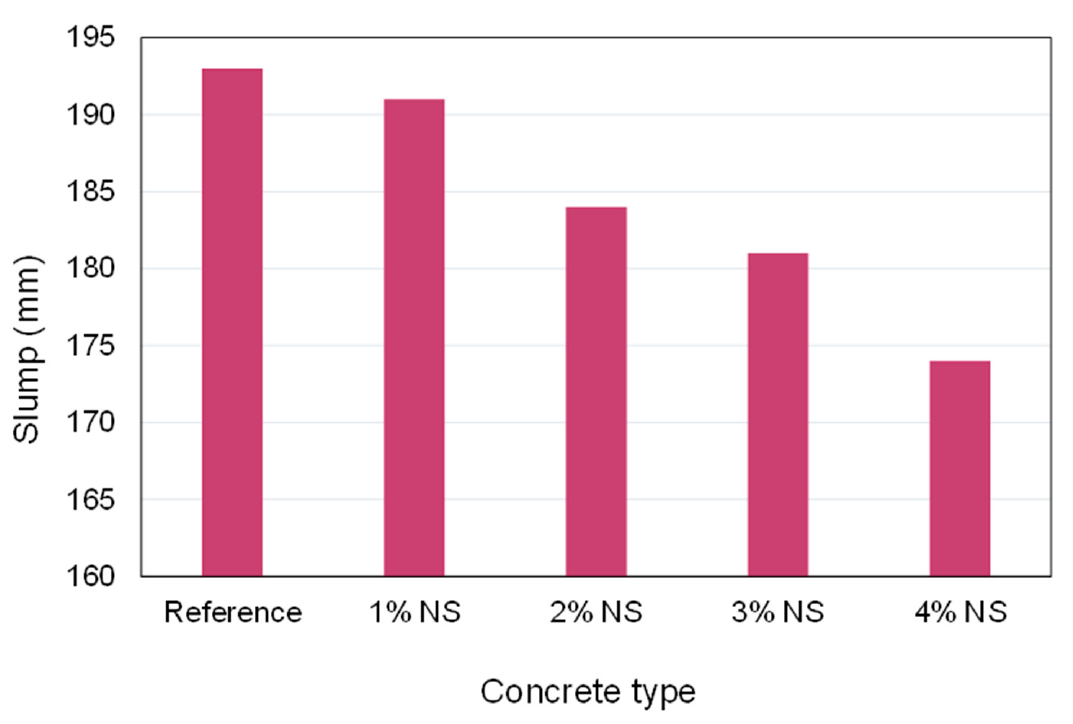
Figure 5. Influence of nano-silica dosage on the slump. Generated from the data obtained from [108].